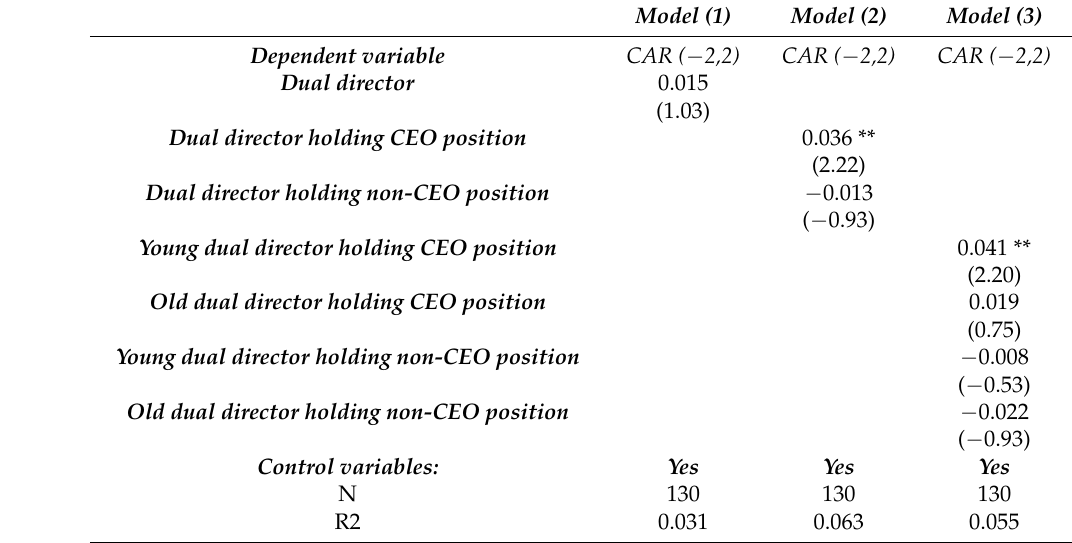
Table A2. Cross-Sectional regressions of announcement period CAR. The dependent variable in all regressions is the five-day CAR surrounding the announcement day of the equity carve-out. ** indicate significance at the 5% levels,